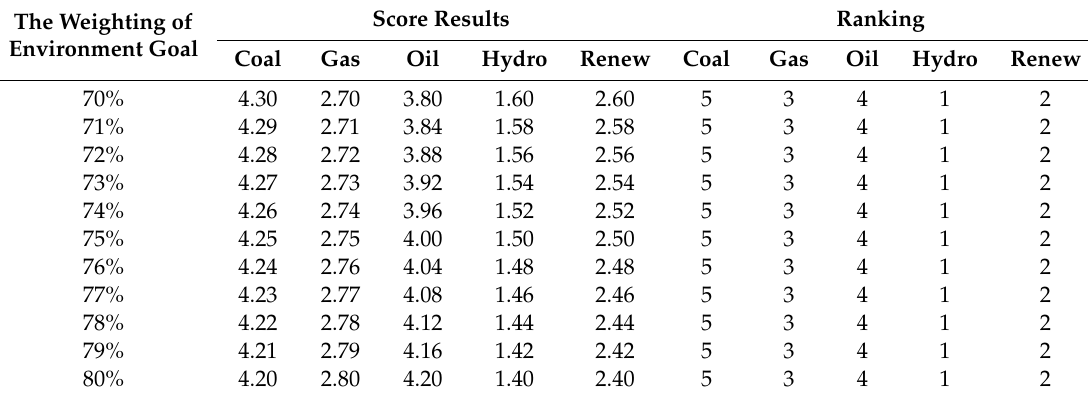
Table A1. Sensitivity analysis for the environmental